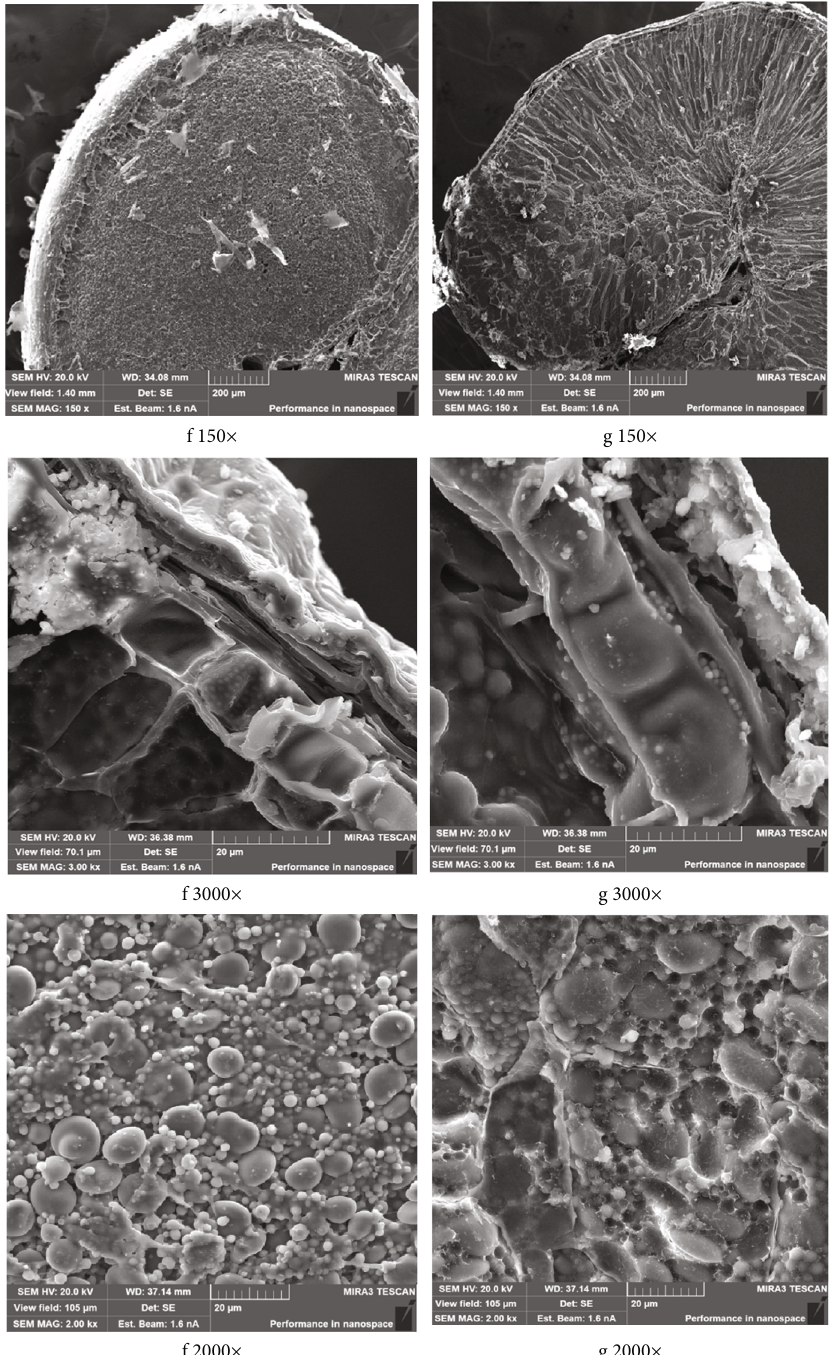
Figure 4: Characteristic view of electronic microphotographs of the cross-section wheat grain samples (Sample 2) after 8 hours of soaking, TESCAN MIRA3 SEM, magni fi cation 150x, 3000x, and